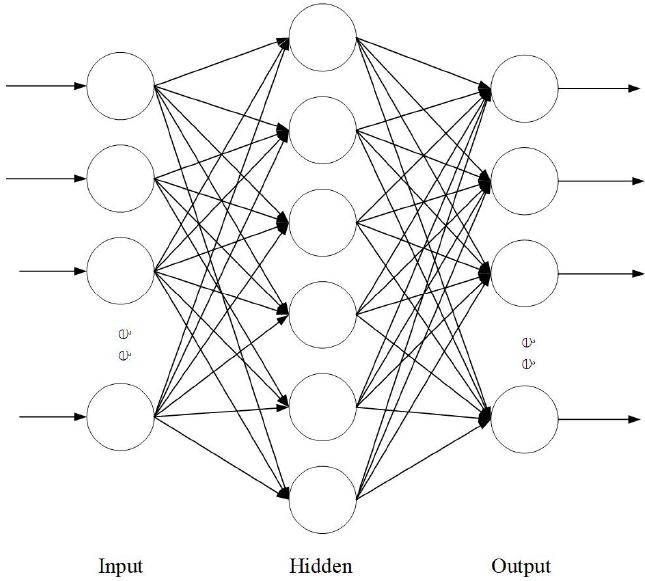
Fig. 1 Model structure of BPNN. BPNN, backpropagation neural